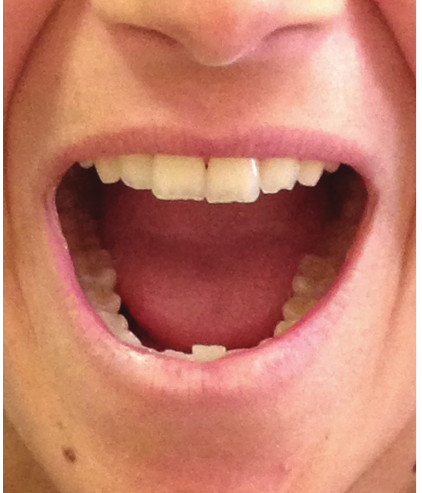
Figure4: A38-year-oldwomanwithmicrostomiabeforetreatment.